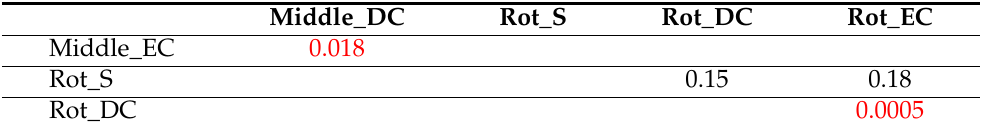
Table A1. Pairwise Wilcoxon rank sum test results for navigation time. The number is marked red when it is statistically significant ( p < 0.05)